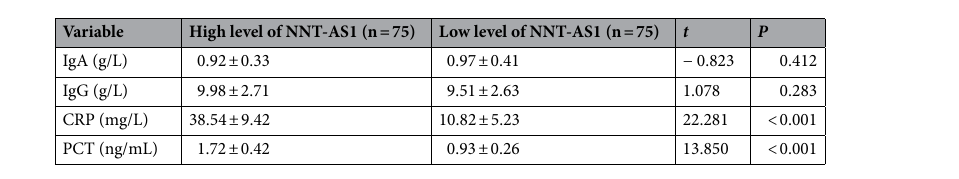
Table 3. Correlation between clinical laboratory indicators and LncRNA NNT-AS1.